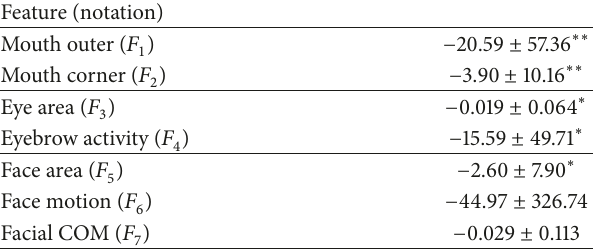
Table 2: Mean of differences ( ± SD) of features between periods 𝐻 0 and 𝐻 1 ( 𝑁 = 59 ). Units expressed in normalized